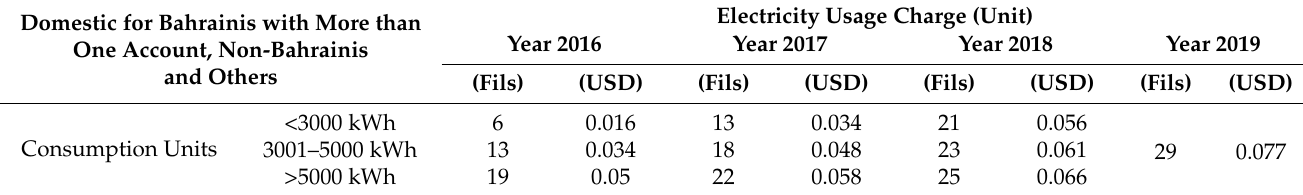
Table 5. Tariff rates for non-Bahrainis and Bahrainis with more than one account (Source: [6]). Domestic for Bahrainis with More than One Account, Non-Bahrainis and